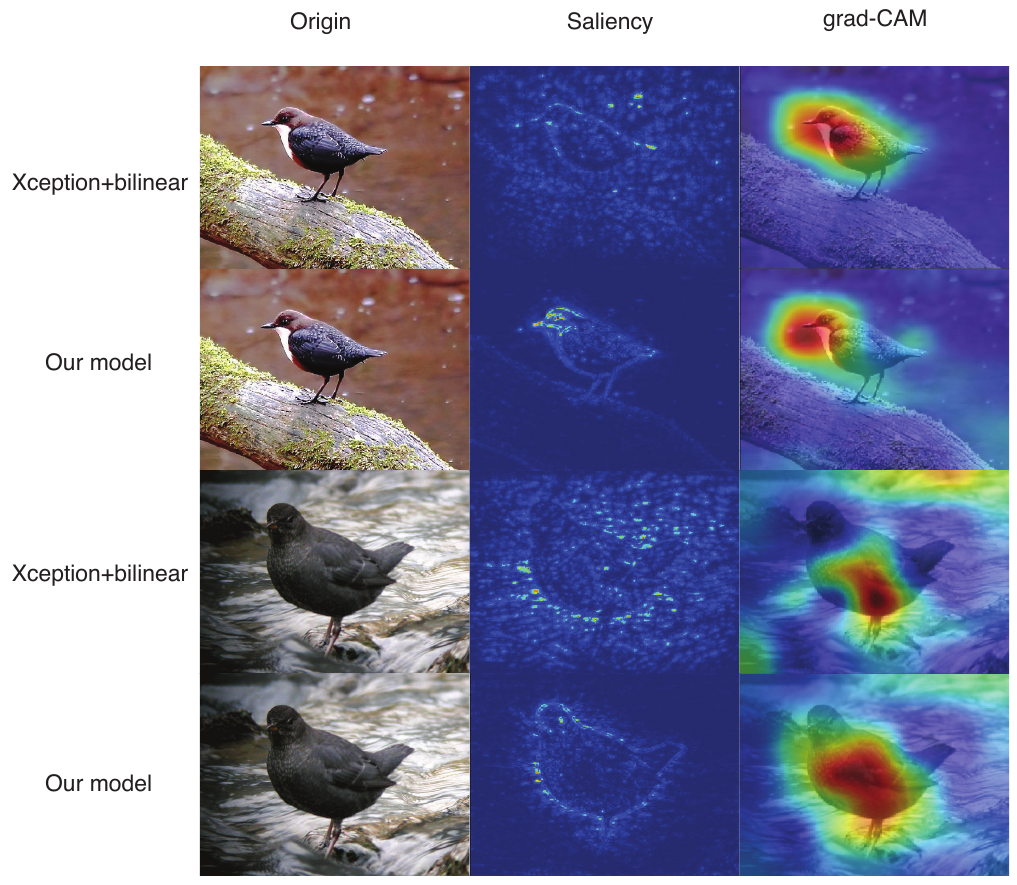
Figure 9. Representative results of our model and the Xception+Bilinear